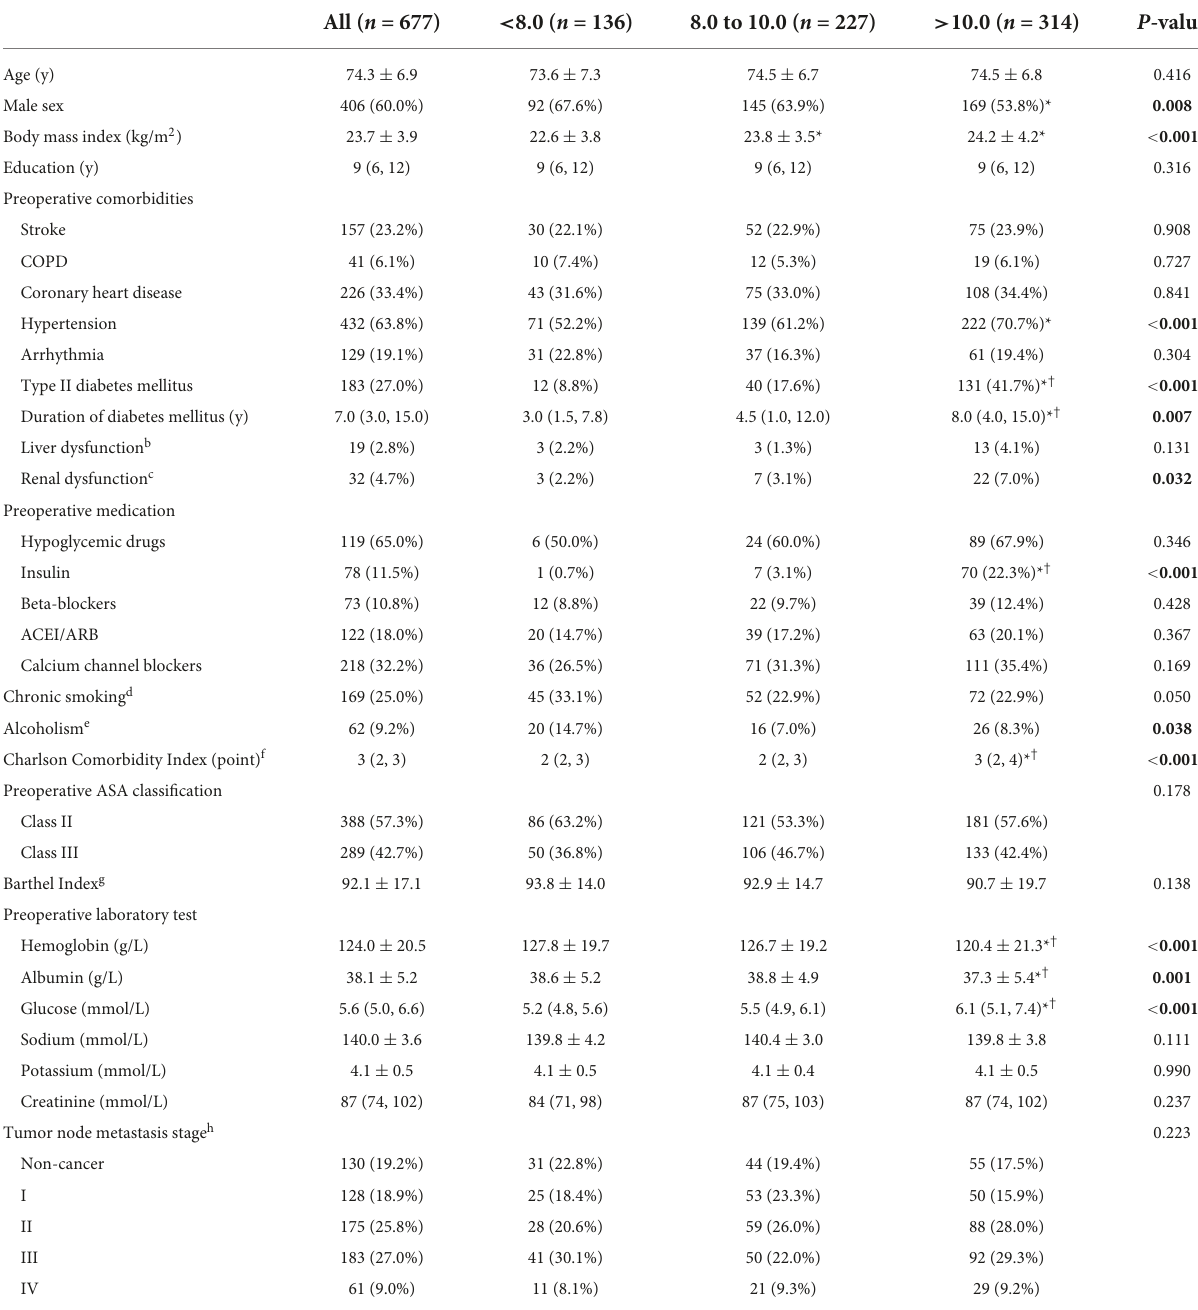
TABLE 1 Baseline